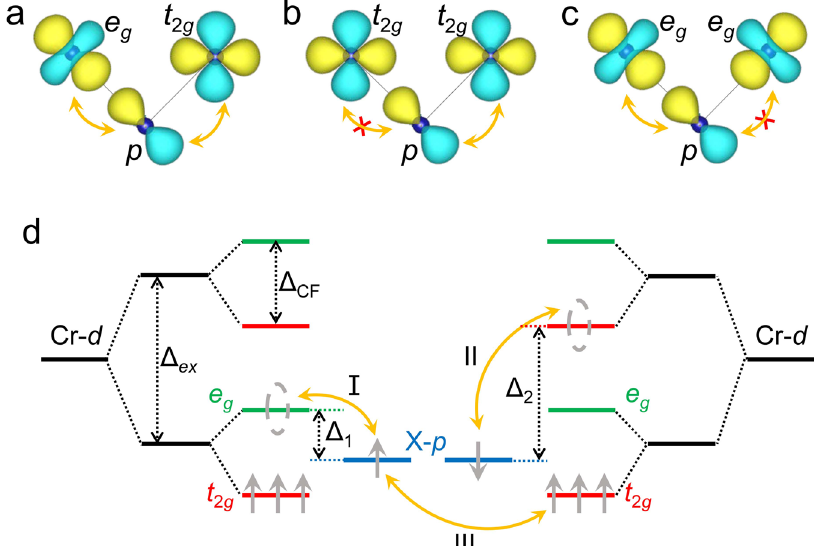
Fig. 3 Ferromagnetic superexchange mechanism. Superexchange channels between two cations via an intermediate anion: ( a ) e g - p - t 2 g , ( b ) t 2 g - p - t 2 g and ( c ) e g - p - e g . d Schematic diagrams of orbital evolution and superexchange interaction. Red and green bars represent t 2 g - and e g - orbitals, respectively. Δ 1 , Δ 2 and Δ CF are the energy difference between e g - and p -orbitals, t 2 g - and p -orbitals and e g - and t 2 g -orbitals, respectively. Process I, II and III represent the electron hopping between p ↑ - and e g ↑ -orbitals, p ↓ - and t 2 g ↓ -orbitals and p ↑ - and t 2 g ↑ -orbitals, respectively. Δ ex is the exchange splits for Cr- d